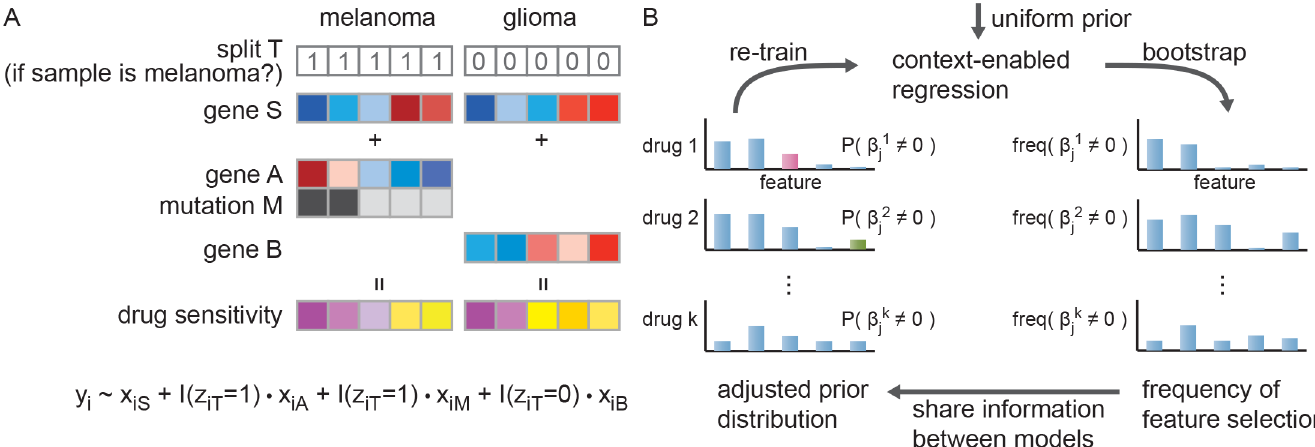
Fig 1. Overview of CHER algorithm. A. Example of a model learned by CHER, where the drug sensitivity of melanoma samples can be predicted by mutation of M and gene expression of A and S, whereas in glioma, expression of gene S and B are the predictors. CHER takes advantage of pooling samples together to gain statistical power, identifying both shared (gene S) and context-specific features (A, B and M). In cases where the relevant context is unknown, the algorithm searches for the best “ split ” , if any, to separate samples into two groups. Yi represents drug sensitivity of the ith sample, xi are the corresponding features of the ith sample, zit = 1 presents the ith sample is melanoma, and I(.) is an indicator function. B. Iterative learning scheme of CHER. CHER initially learns models with uniform prior (meaning each genomic feature has the same probability of being included in the model). During each iteration, CHER trains the regression models with bootstrapping, which allows the algorithm to establish the frequency of each feature being selected. Then CHER adjusts the priors according to the distribution of frequency and the similarity between phenotypes.